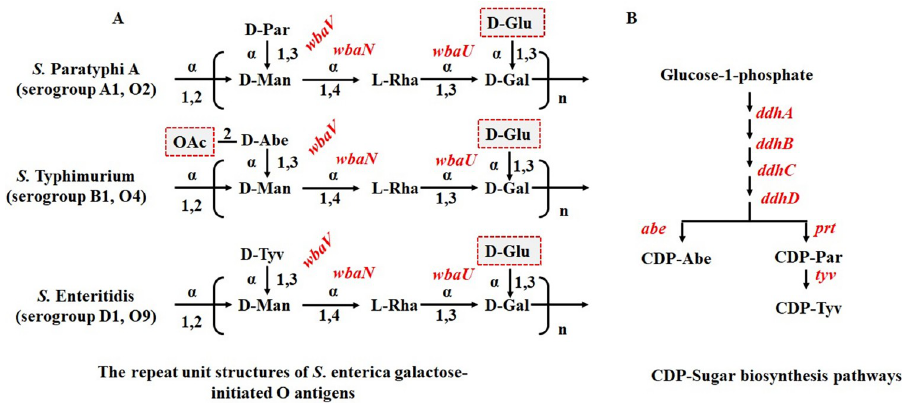
Fig 1. S. enterica group A1, B1 and D1 O-unit structures and the CDP-Sugar biosynthesis pathways. (A) Square brackets denoted a single O-unit repeat. The arrows represented the linkages with the linkage types and the glycosyltransferase (GT) indicated. Note that the S . Paratyphi A, S . Enteritidis and S . Typhimurium all share a common trisaccharide backbone. The side-branch sugar of group A1, B1 and D1 was Par, Abe and Tyv, respectively, creating epitopes O2, O4 and O9. Note that the O-antigen galactose can be variably glucosylated, creating epitopes O:12 and O:1. Further, S. Typhimurium can variably O-acetylate its abequose in the C-2 position, creating epitope O:5. (B) Gene responsible for each glycosidic linkage synthesis was indicated adjacent to each arrow. The CDP-Sugars synthesis pathways are all initiated from glucose-1-phosphate. The genes involved in each reaction step of pathways were shown alongside the arrows. Abbreviations: Abe, abequose; Tyv, tyvelose; D-Man, D-mannose; D-Gal, D- galactose; L-Rha, L-rhamnose.